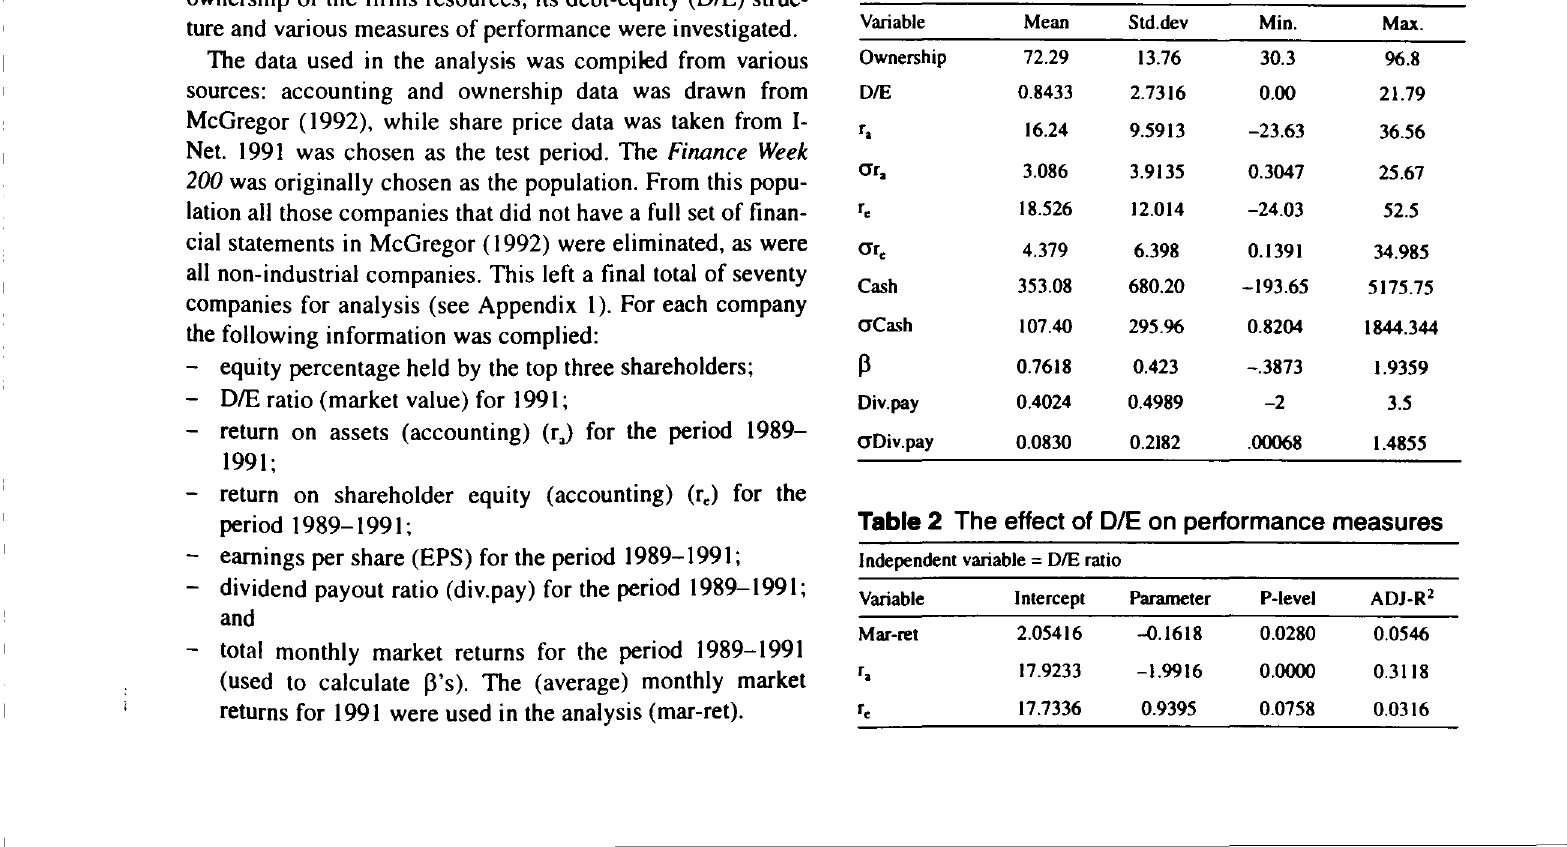
Table 1 Summary statistics of data